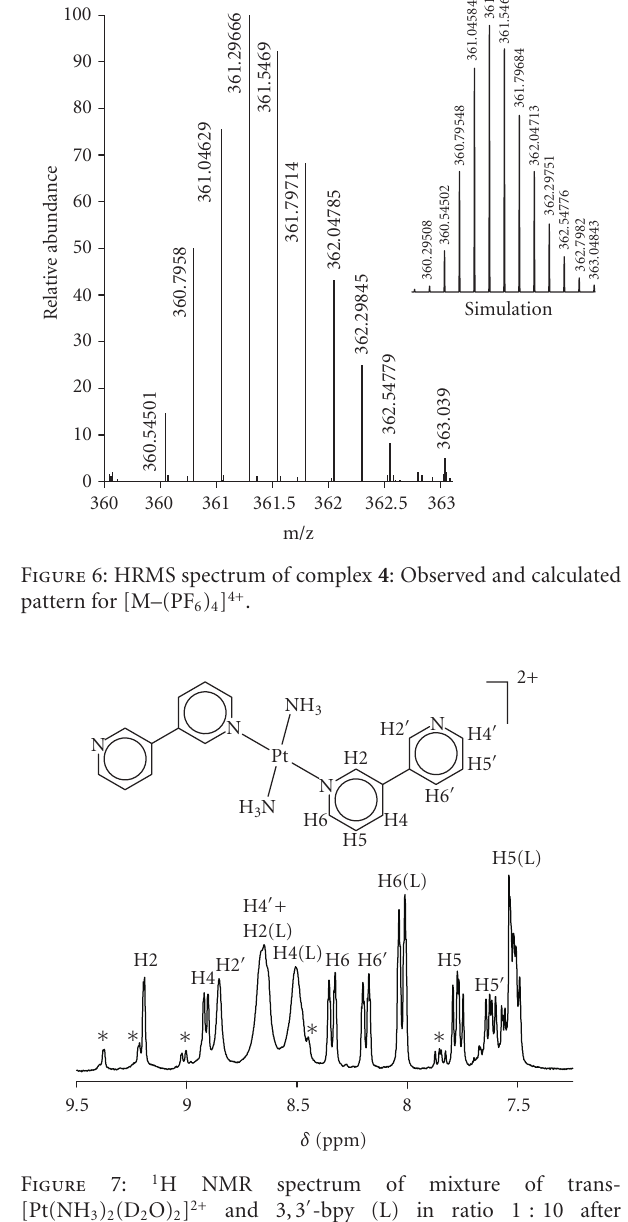
2d, 50 ◦ C, D 2 O, pD = 6.65. Main resonances are assigned to 1 : 2